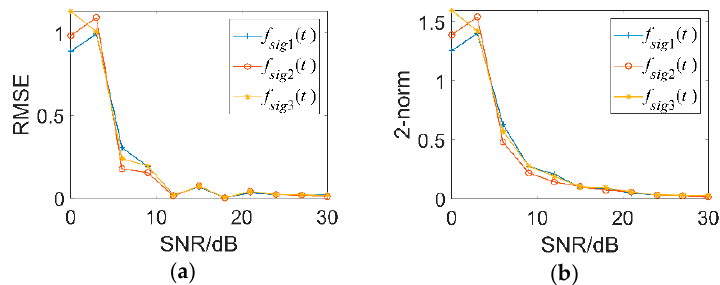
12 of 20 Figure 4. Analysis results with SNR = 12 dB. ( a ) The estimated modes by VSME. ( b ) Frequency of estimated component signal extracted by VSME. ( c ) Absolute error of estimated component signal frequency extracted by VSME. (a) (b) (c) Figure 5. Analysis results with SNR = 18 dB. ( a ) The estimated modes by VSME. ( b ) Frequency of estimated component signal extracted by VSME. ( c ) Absolute error of estimated component signal frequency extracted by VSME.